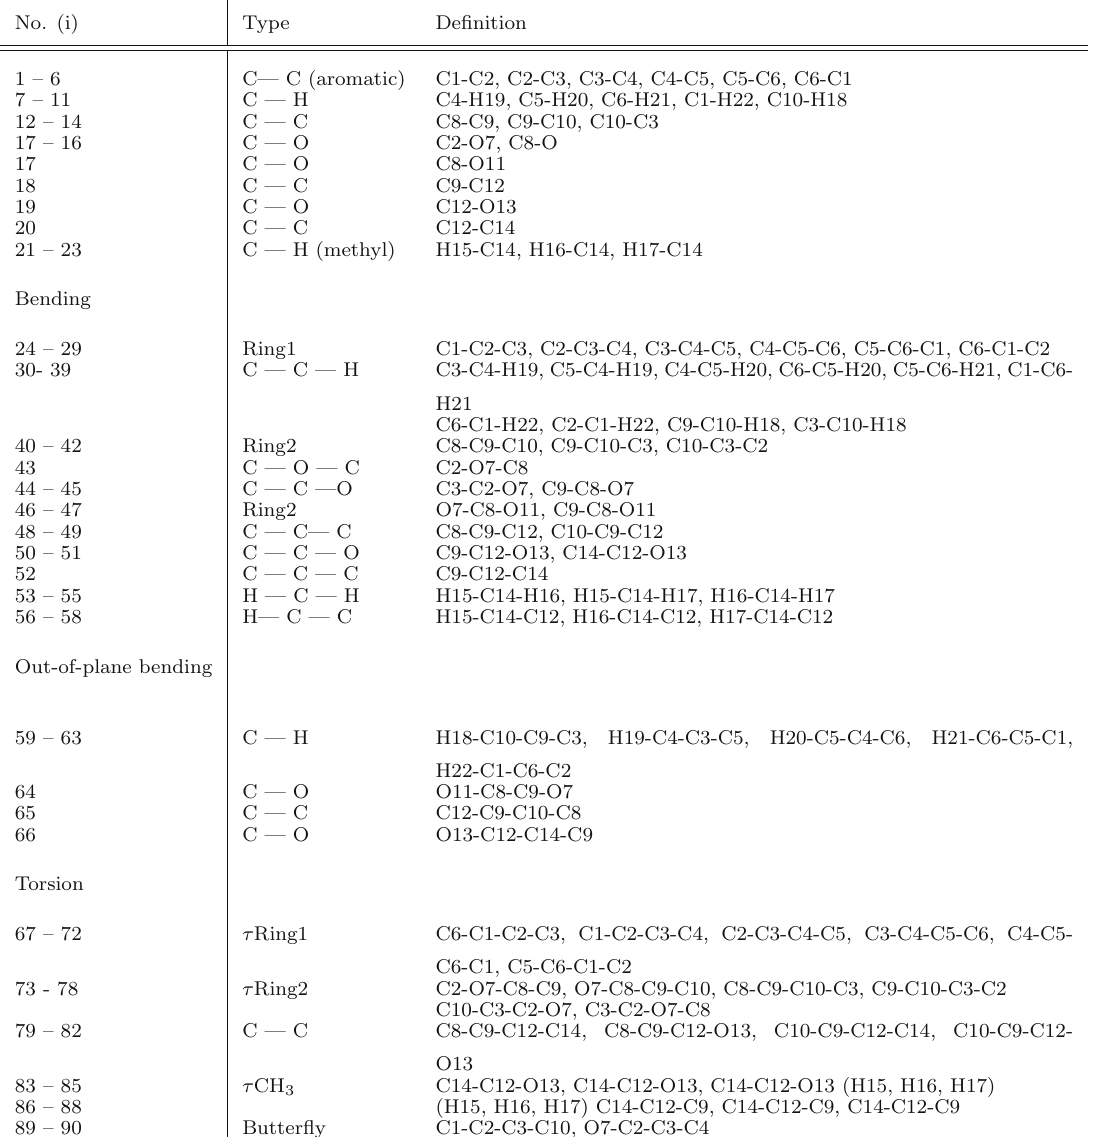
Table 3 Definition of internal coordinates of acetyl